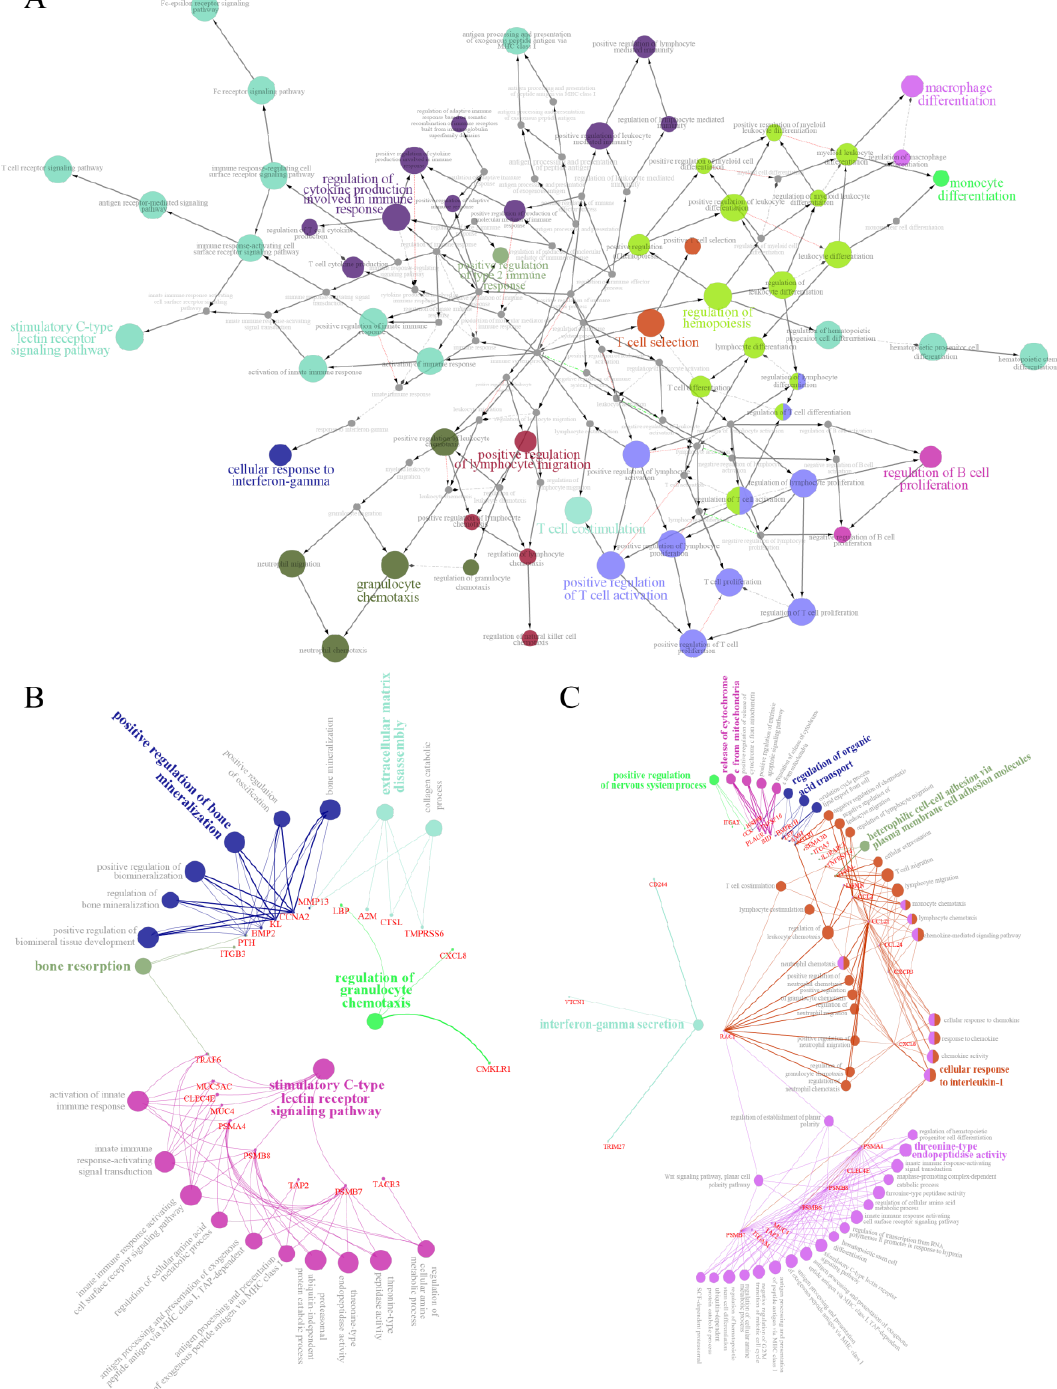
Figure 5. Gene co-expression network analysis. ( A ) Co-expression network of 3854 immune genes in transcriptome of blunt snout bream, where nodes indicate different pathways. ( B ) Co-expression network of top 100 immune genes expressed in females. ( C ) Co-expression network of top 100 immune genes expressed in males.